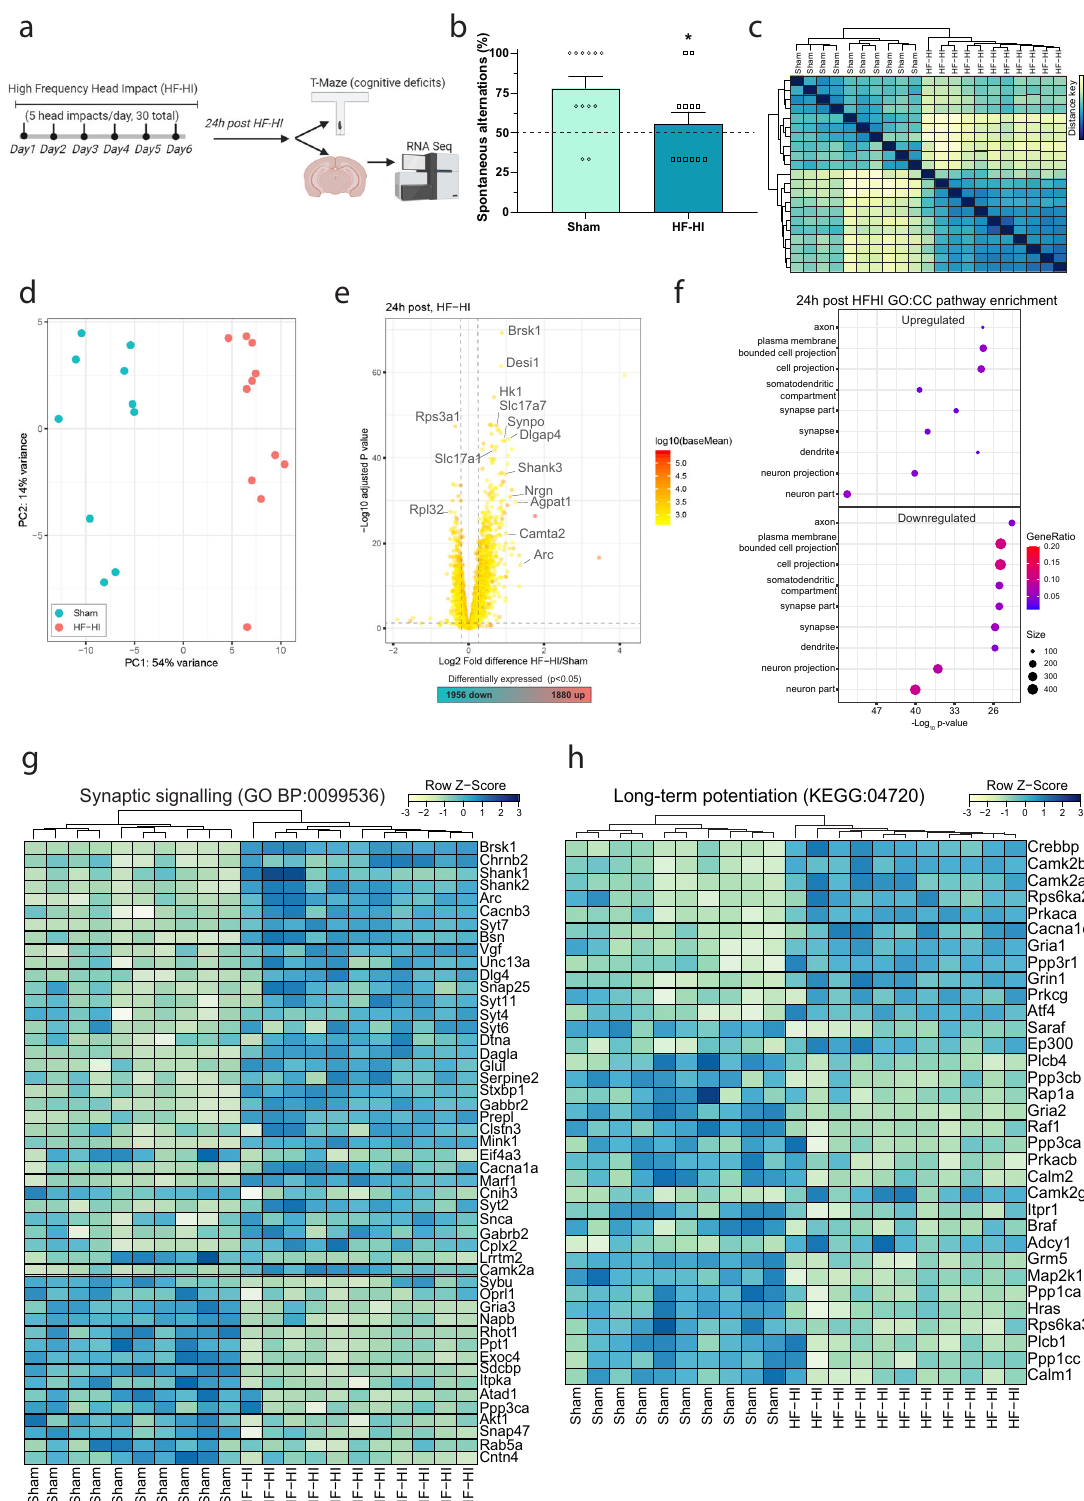
(Supplementary Fig. 4B), or the 1 month cortex (Supplementary Fig. 4E) or hippocampus (Supplementary Fig. 4F). HF-HI did not change A β 40 levels in the cortex or hippocampus at 1 day or 1 month post impact (Supplementary Fig. 4C, D). These results demonstrate that the acute cognitive de fi cits of HF-HI are correlated with a change in the synaptic transcrip- tome, but not with in fl ammation, p-tau, or A β